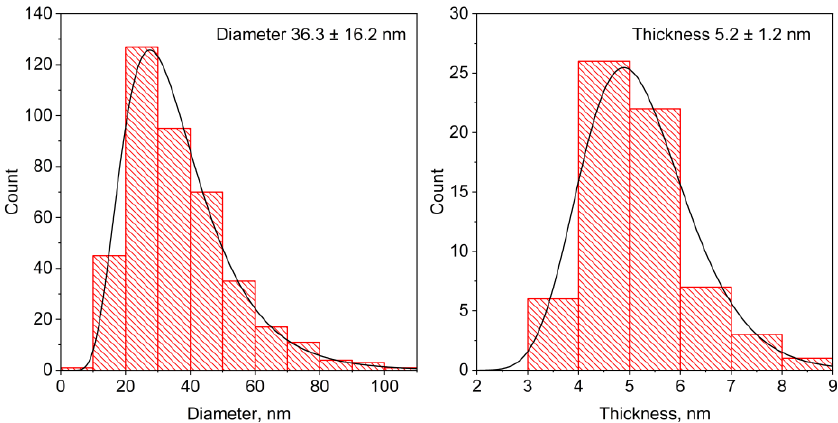
Figure A2. Particle diameter and thickness distributions of SHF sample obtained from TEM data.